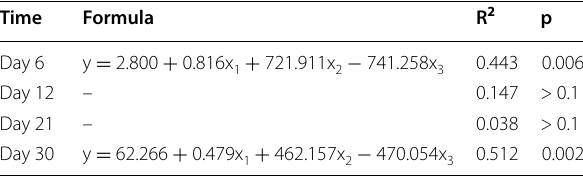
Table 3 Multiple regression analysis between zinc leach- ing efficiency and mineral composition on sampling